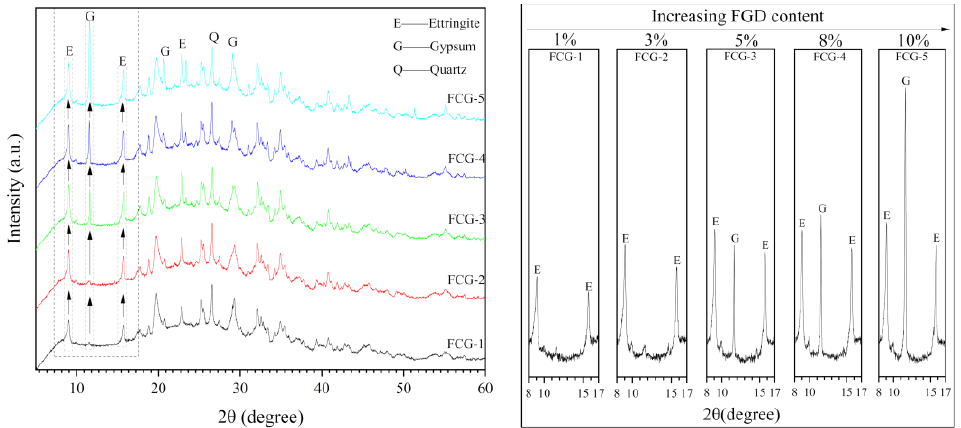
Figure 6. XRD patterns of FCG pastes for different FGD in 28 days.